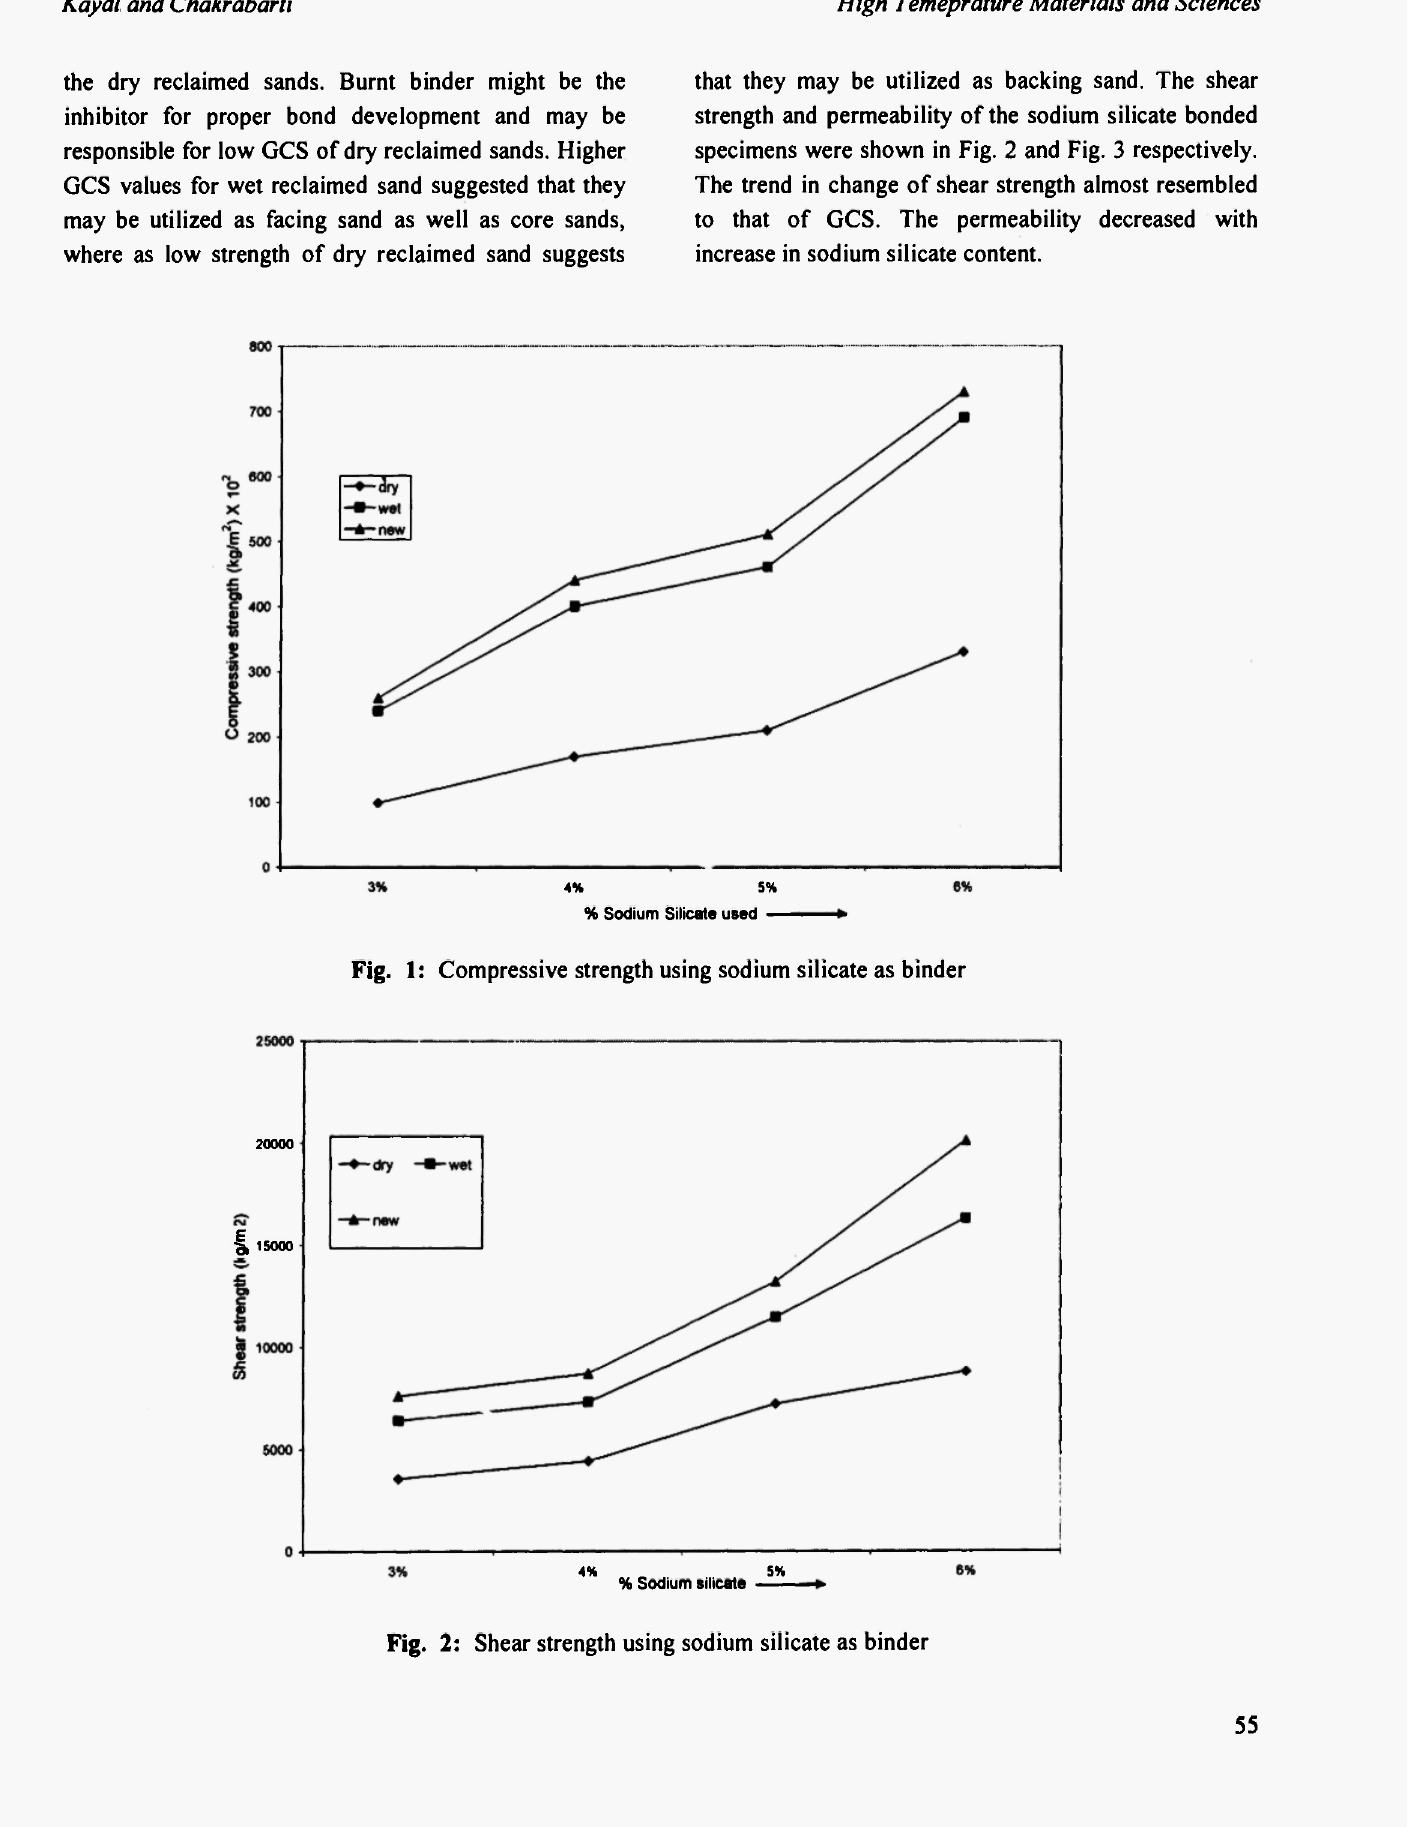
Fig. 2: Shear strength using sodium silicate as